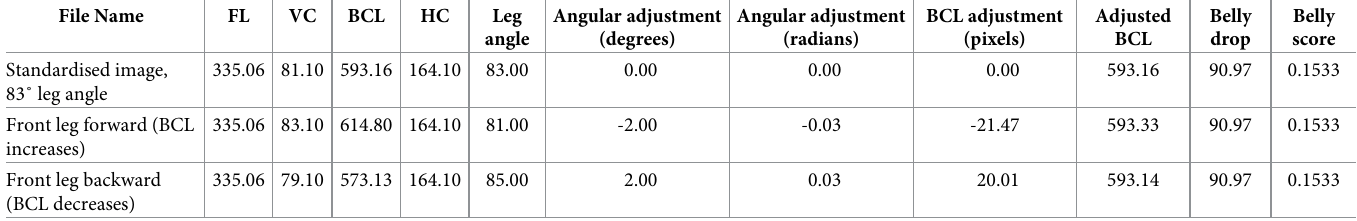
Table 3. Example of Excel spreadsheet for morphometric measurement data entry. Formulaes to calculate belly scores for Lycaon pictus from these measurements are entered into the appropriate cells.